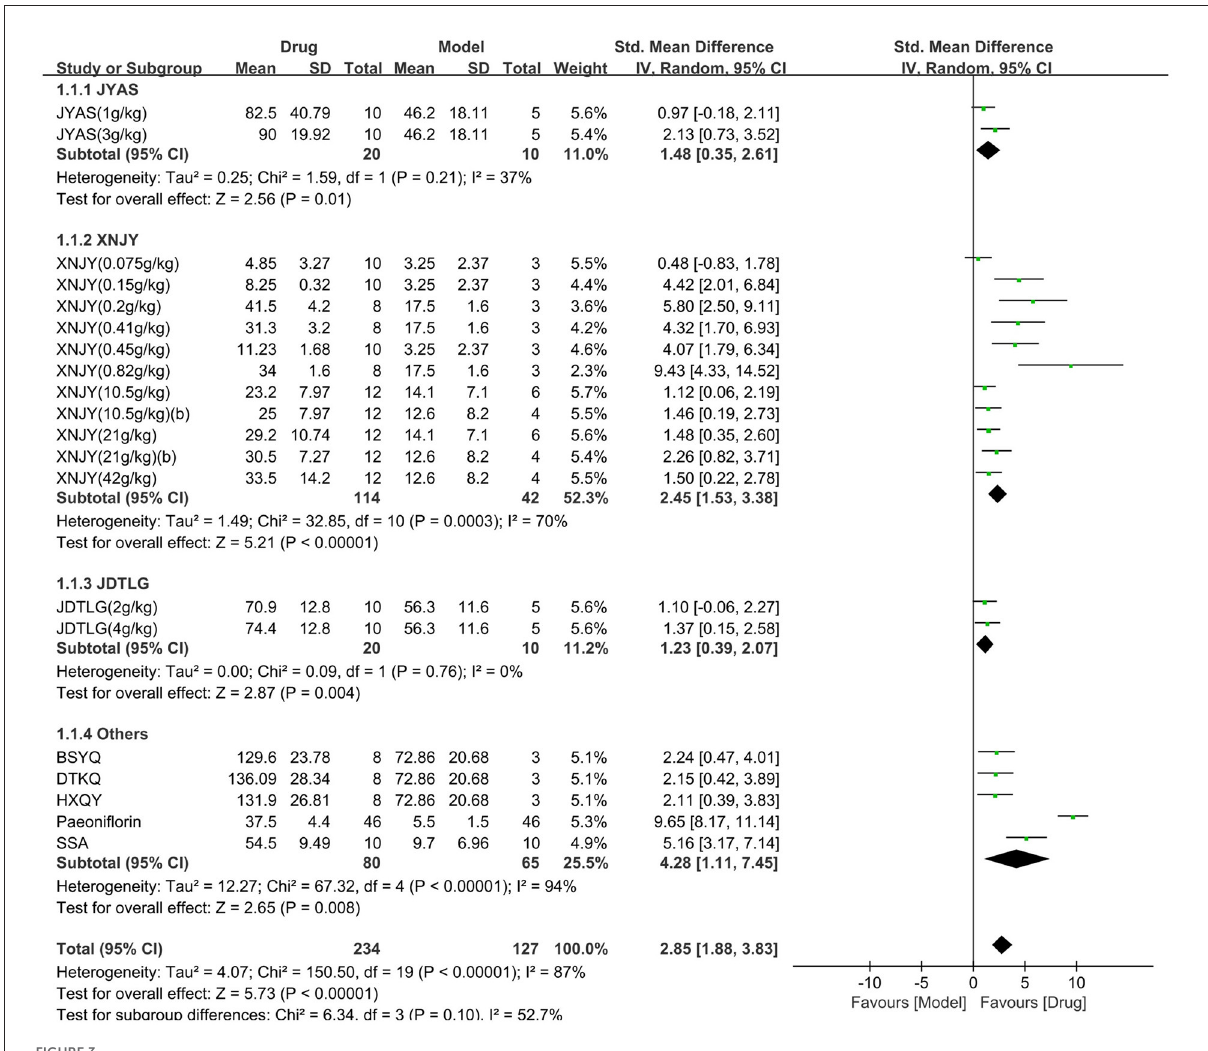
FIGURE3 Efficacy of CHM on the open-field test. Forest plots of the effect size calculated using SMDs. The horizontal error bars represent the 95% confidence interval of individual